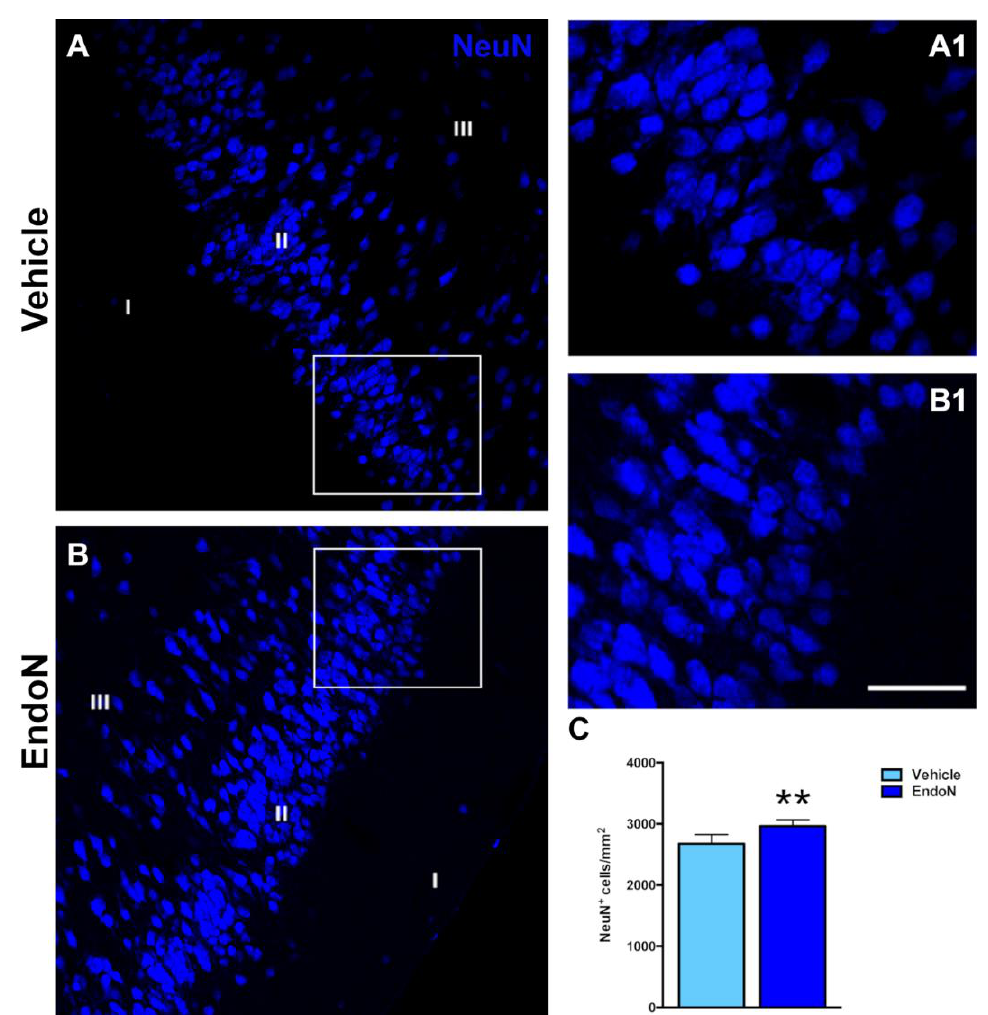
Figure 4. Effects of Endo-N injection on the density of NeuN-expressing cells. ( A , B ) Single confocal sections showing the expression of NeuN in the PCX. ( A1 , B1 ) are higher magnifications of the squared areas in ( A , B ), which show the different densities of NeuN immunoreactive nuclei in the PCX layer II. ( C ) Graph showing the effect of Endo-N injection on the density of NeuN immunoreactive nuclei in the PCX layer II. Asterisks indicate statistically significant differences between hemispheres (vehicle vs. Endo- N) after paired Student’s t- test. (** p < 0.01). Scale bar represents 70 µm for ( A , B ) and 120 µm for ( A1 , B1 ).